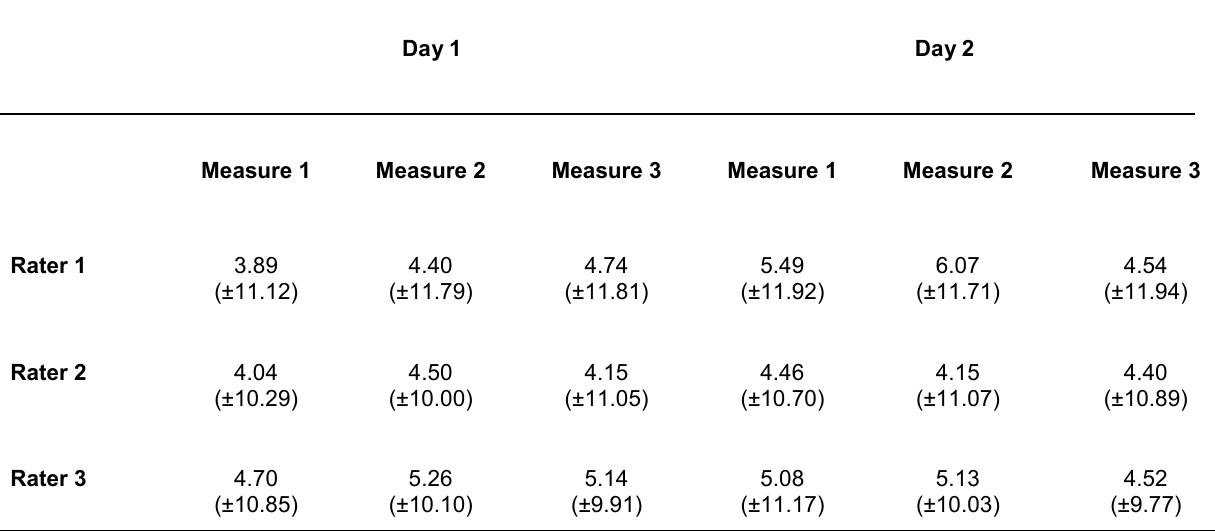
Mean and Standard Deviation of the Knee Frontal Plane Projection Angle of 22 Knees Measured by Three Raters, Three Times, on Two Different Days